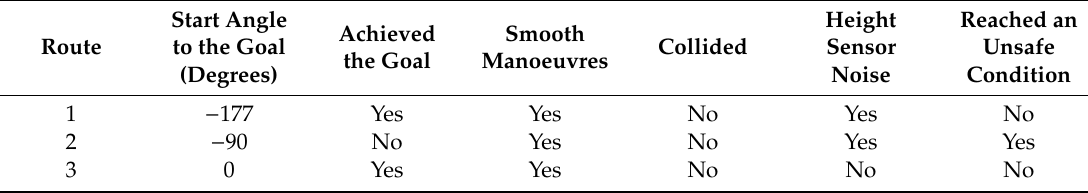
Table 4. Summary of test observation